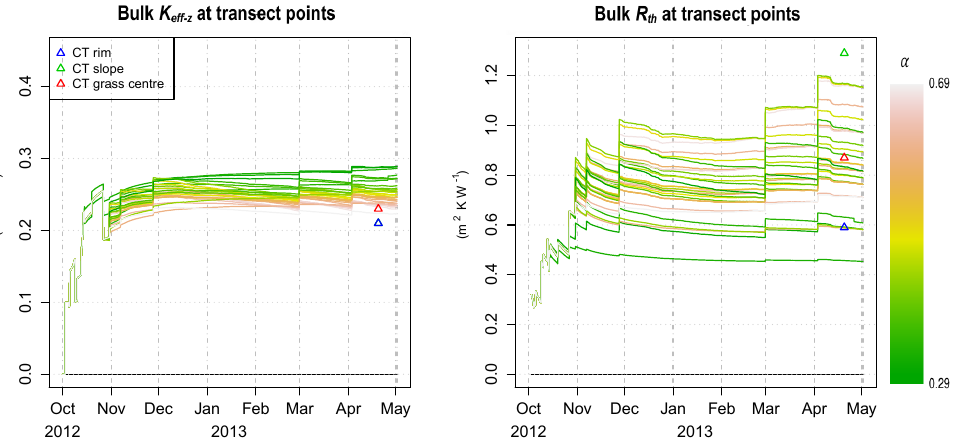
Figure B2. Simulated K eff − z and R th time series at the 31 transect data points. Overlain are the bulk properties estimated at the rim, slope, and grass-centre CT sites.